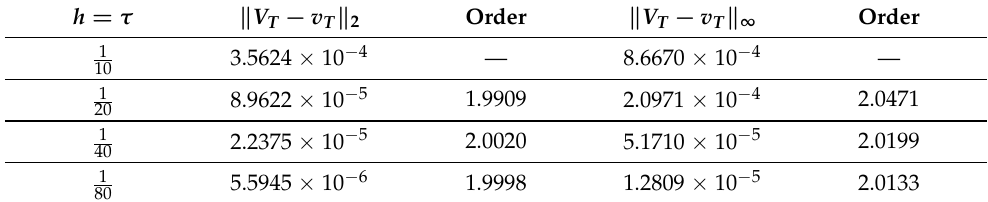
Table 1. Numerical errors and convergence orders of the ADI